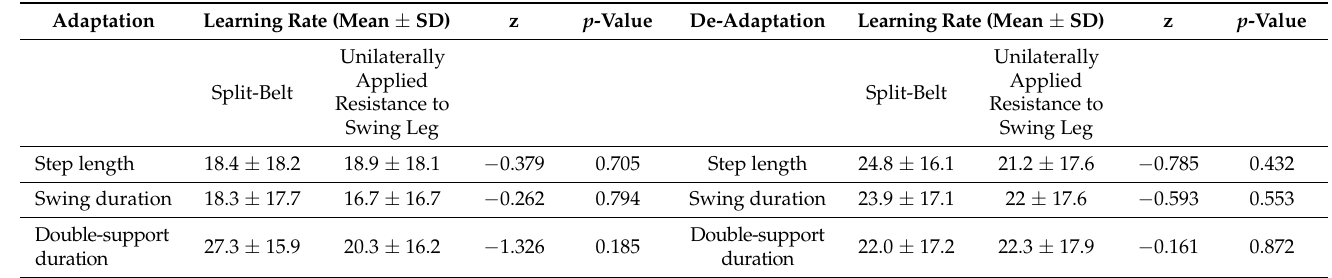
Table 3. Rates of adaptation and de-adaptation during walking on the split-belt treadmill vs. unilat- erally applied resistance to swing leg during